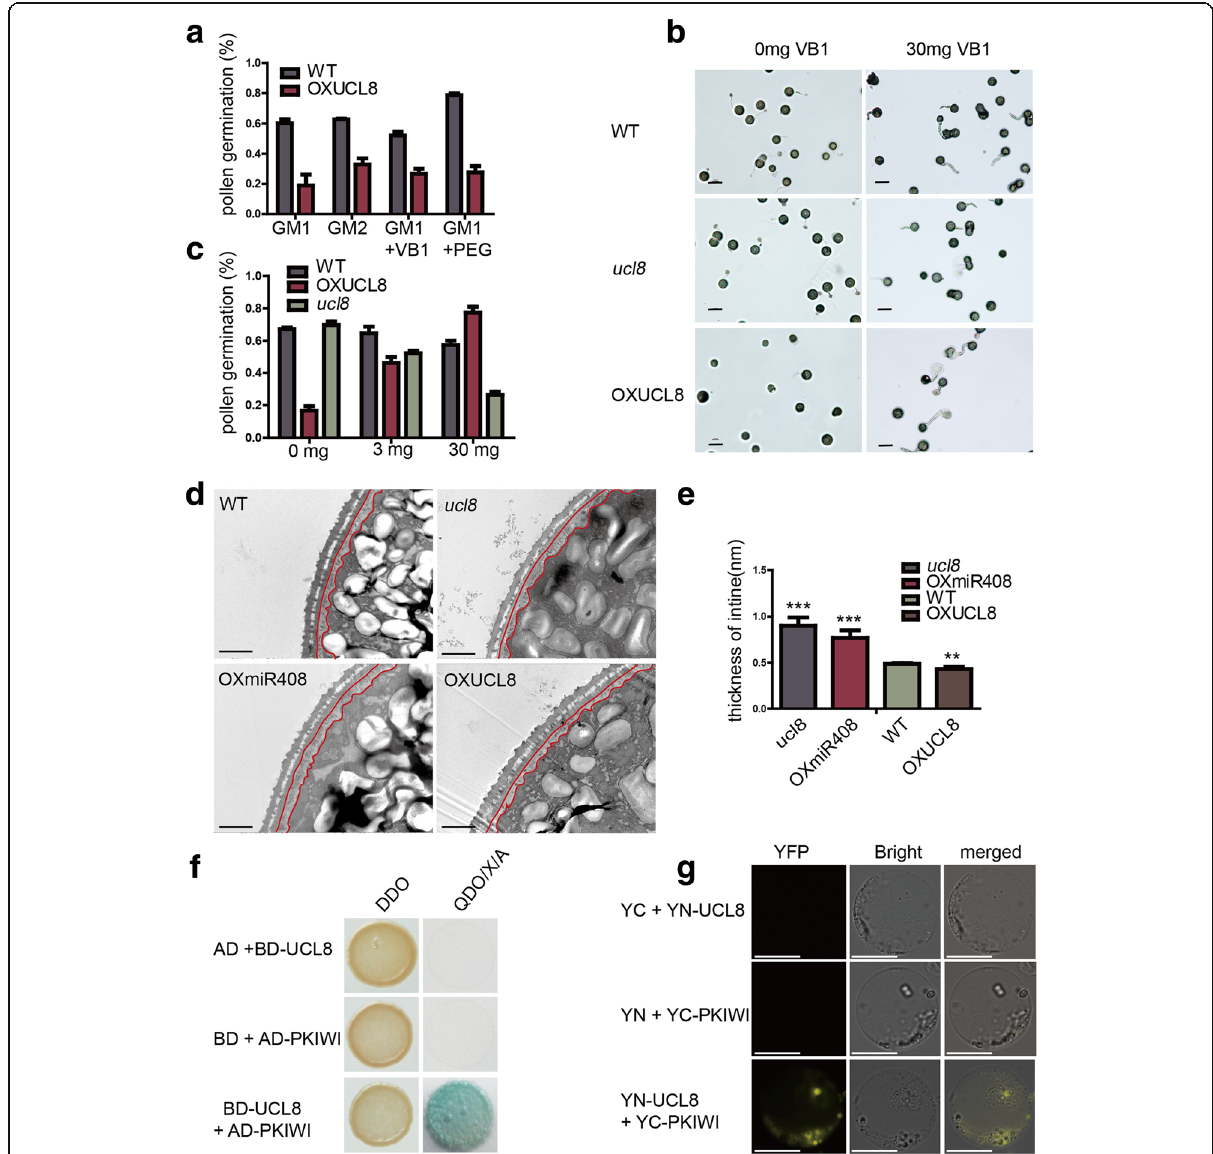
Fig. 2 OsUCL8 regulates pollen intine and interacts with OsPKIWI protein. ( a ) Pollen germination rate of WT and mutants in different germination mediums,values are the means ± s.d. ( n = 480 pollens from 3 plants). ( b ) Pollen germination of WT, ucl8 and OXUCL8 pollens in GM1 with 0 or 30 mg/L VB1. Scale bars, 100 μ m. ( c ) Pollen germination rate of WT, ucl8 and OXUCL8 pollens in GM1 with 0, 3 and 30 mg/L VB1, values are the means ± s.d. ( n = 480 pollens from 3 plants). ( d ) Observation of the ultrastructure of pollen wall for WT, OXUCL8, ucl8 and OXmiR408 by TEM. The parts surrounded by red lines are intine, Scale bars, 2 μ m. ( e ) The statistical results of intine thinkness, values are the means ± s.d. ( n ≧ 77 pollens). ( f ) Detection of OsUCL8-OsPKIWI interaction with a yeast two-hybrid assay. The combinations of AD/BD-OsUCL8 and AD-OsPKIWI/BD were used as negative controls. ( g ) Verification of the interaction between OsUCL8 and OsPKIWI by BiFC assay in rice protoplasts. Empty YC and YN were used as negative controls. Scale bars, 10 μ m. Asterisks (***) indicate P value < 0.0001 (t tests), Asterisks (**) indicate P value < 0.01 (t